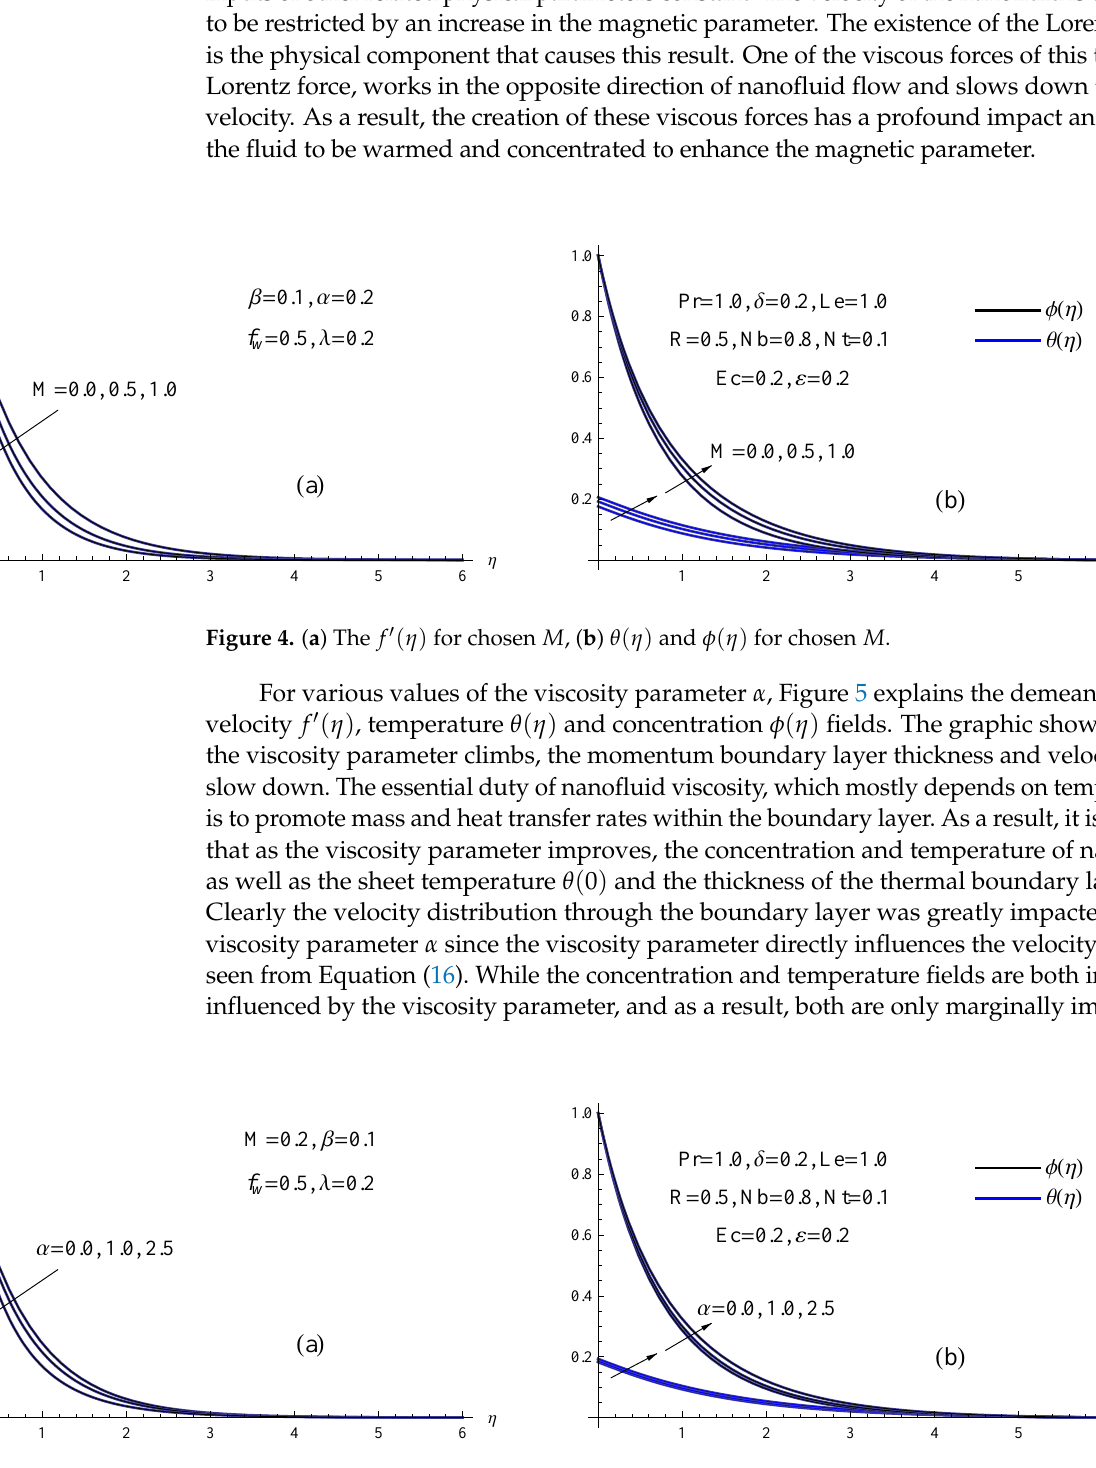
Figure 5. ( a ) The f (cid:48) ( η ) for chosen α , ( b ) θ ( η ) and φ ( η ) for chosen α . Figure 6 examines the impact of the slip velocity parameter λ on the velocity f (cid:48) ( η ) , temperature θ ( η ) and concentration φ ( η ) fields while the other physical governing pa- rameters are unchanged. We notice that anytime the slip velocity λ increases, both the sheet velocity f (cid:48) ( 0 ) and the nanofluid velocity f (cid:48) ( η ) dramatically decrease with the